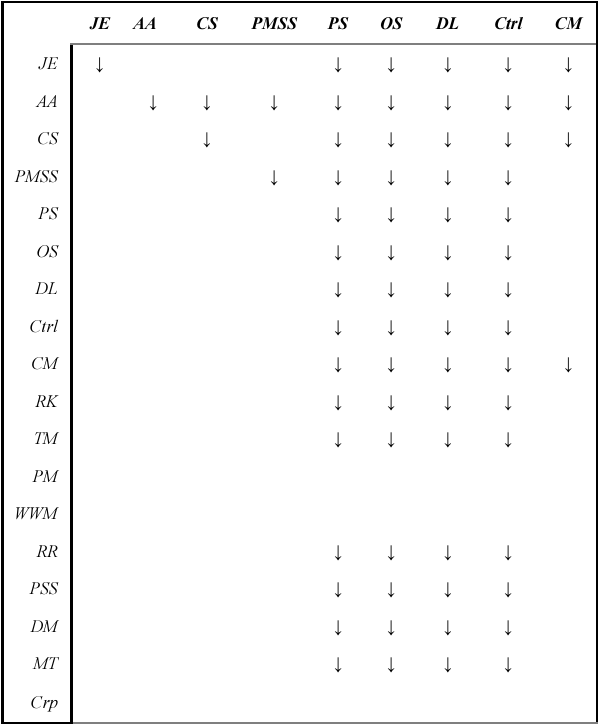
Table 3. Interactions in the sub-criteria level